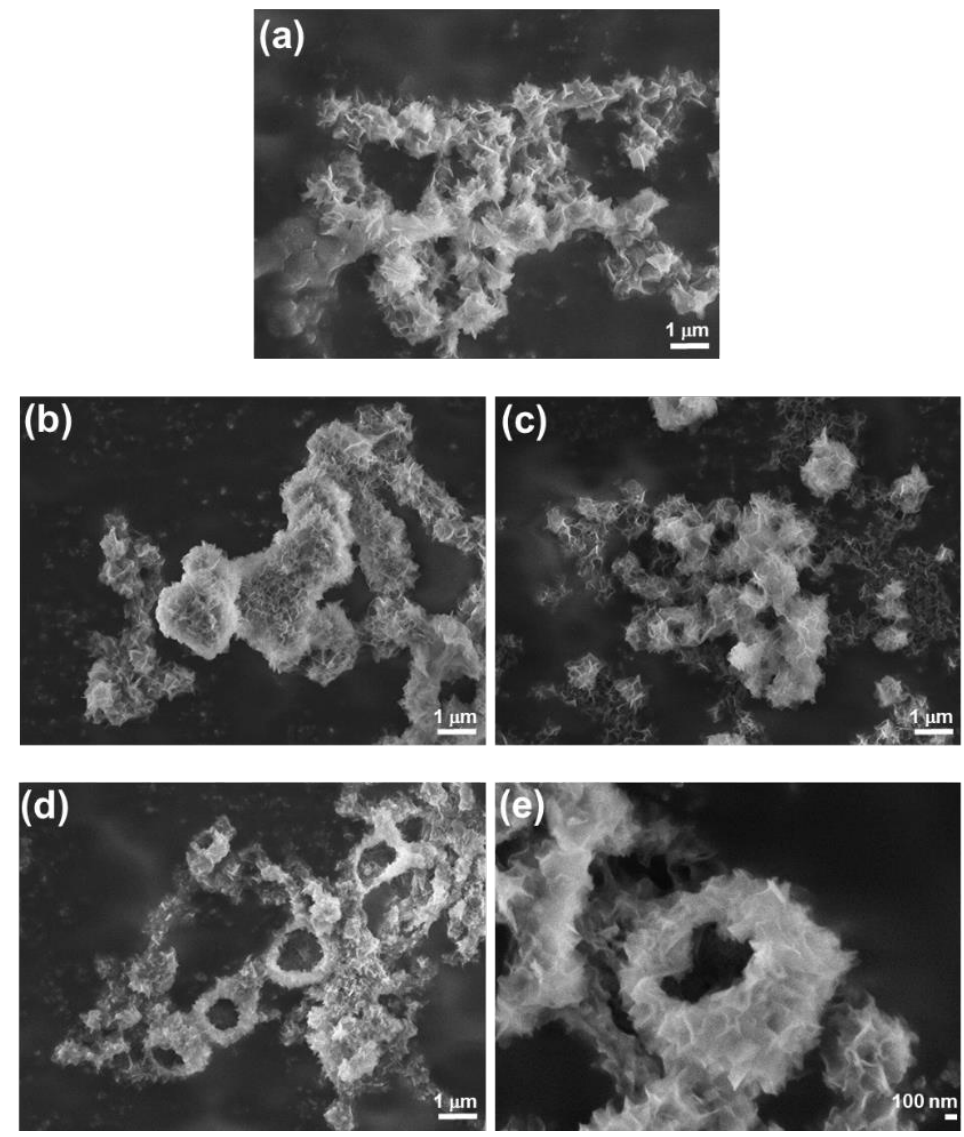
Figure 4. SEM micrographs of the precipitates formed after 60 min reaction time in the ( a ) absence (CS) and presence of different liposomes: ( b ) DMPC, ( c ) EPC, and ( d , e ) DMPS. c i (Ca) = c i (PO 4 ) = 3.5 mmol dm −3 ; γ (lipid) = 25.0 ppm; pH i = 7.4; ϑ /°C = 25 ± 0.1.